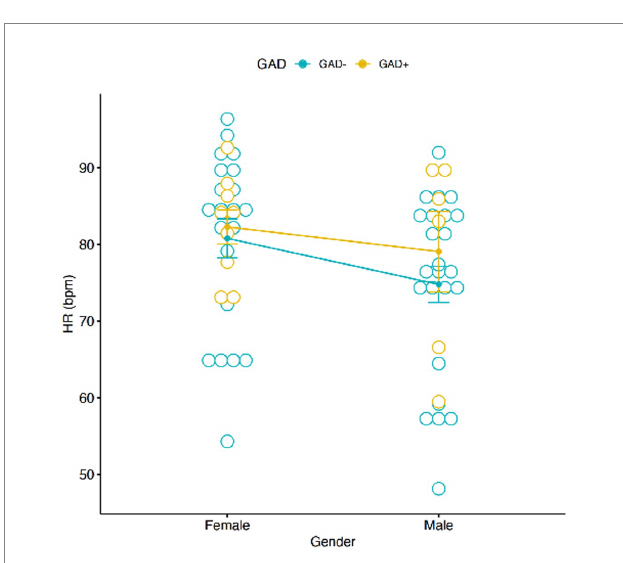
FIGURE 6 Graphic distribution of HR values according to GAD ± and Gender. No significant interaction was found between Gender, HR and GAD